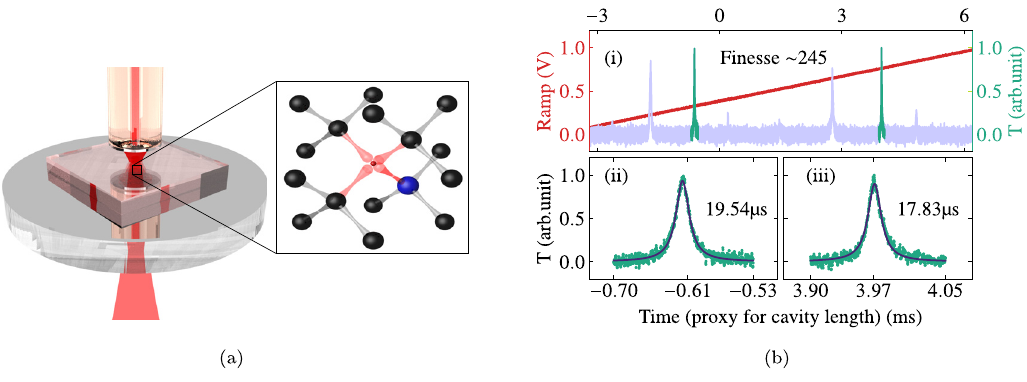
Figure 1: The diamond-loaded fibre cavity platform. (a) Schematic of the fibre cavity loaded with a diamond sample containing nitrogen- vacancy (NV) centres. The diamond sample is placed on top of the macroscopicmirror, and a concavefibre-end mirror is approached from the top forming a stable Fabry – Perot microcavity. The inset displays the structure of the NV − centre within the diamond lattice. Black spheres are carbon atoms, blue indicates nitrogen, and red illustrates the danglingbonds that form electronorbitals around the vacancyposition. (b) The cavity fi nessewas measured by applying a triangularvoltage ramp (red)to the piezo inorder to tunethe cavitylength by movingthe fi bre. The cavity transmission T was measured (shown here normalised to the maximum value), and multiple peaks were typically observed corre- sponding to different spatial modes. The ratio of distance between two peaks of matching (e.g. fundamental) mode to the full width at half maximum gives the cavity fi nesse. Note these representative transmission data do not come from the same cavity as the subsequent ampli fi cation